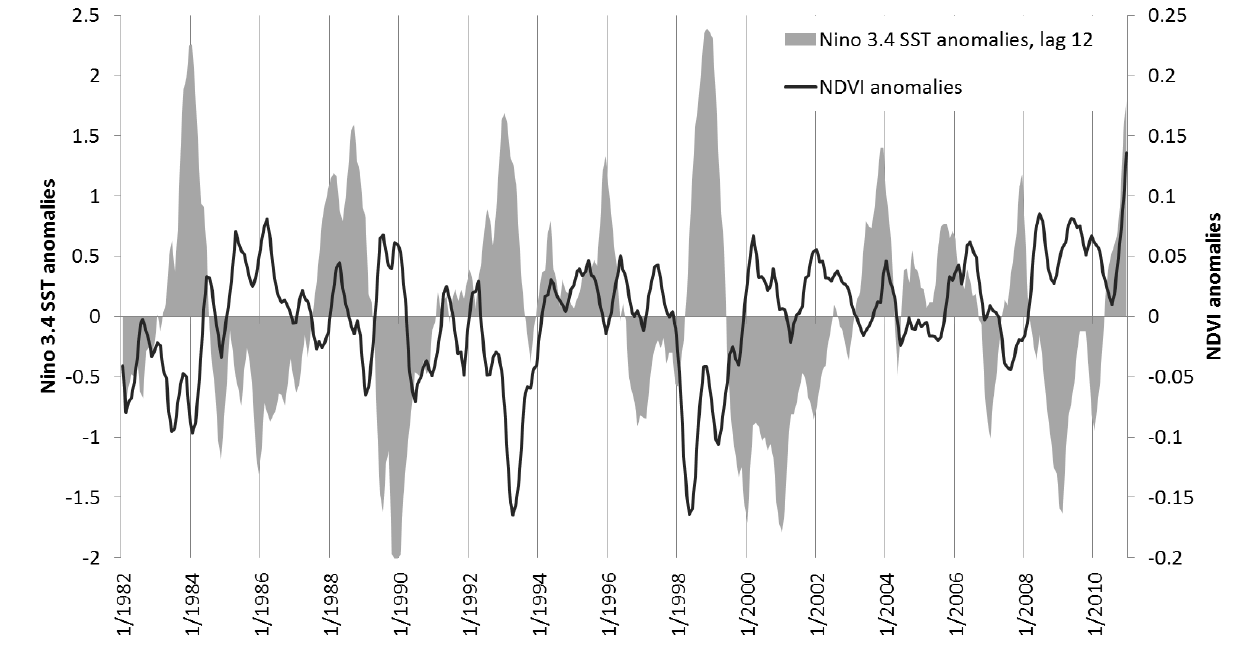
Figure 9. The temporal profile of monthly NDVI3g anomalies for the focus region of Serido, compared to monthly Nino 3.4 SST anomalies with a temporal lag of +12